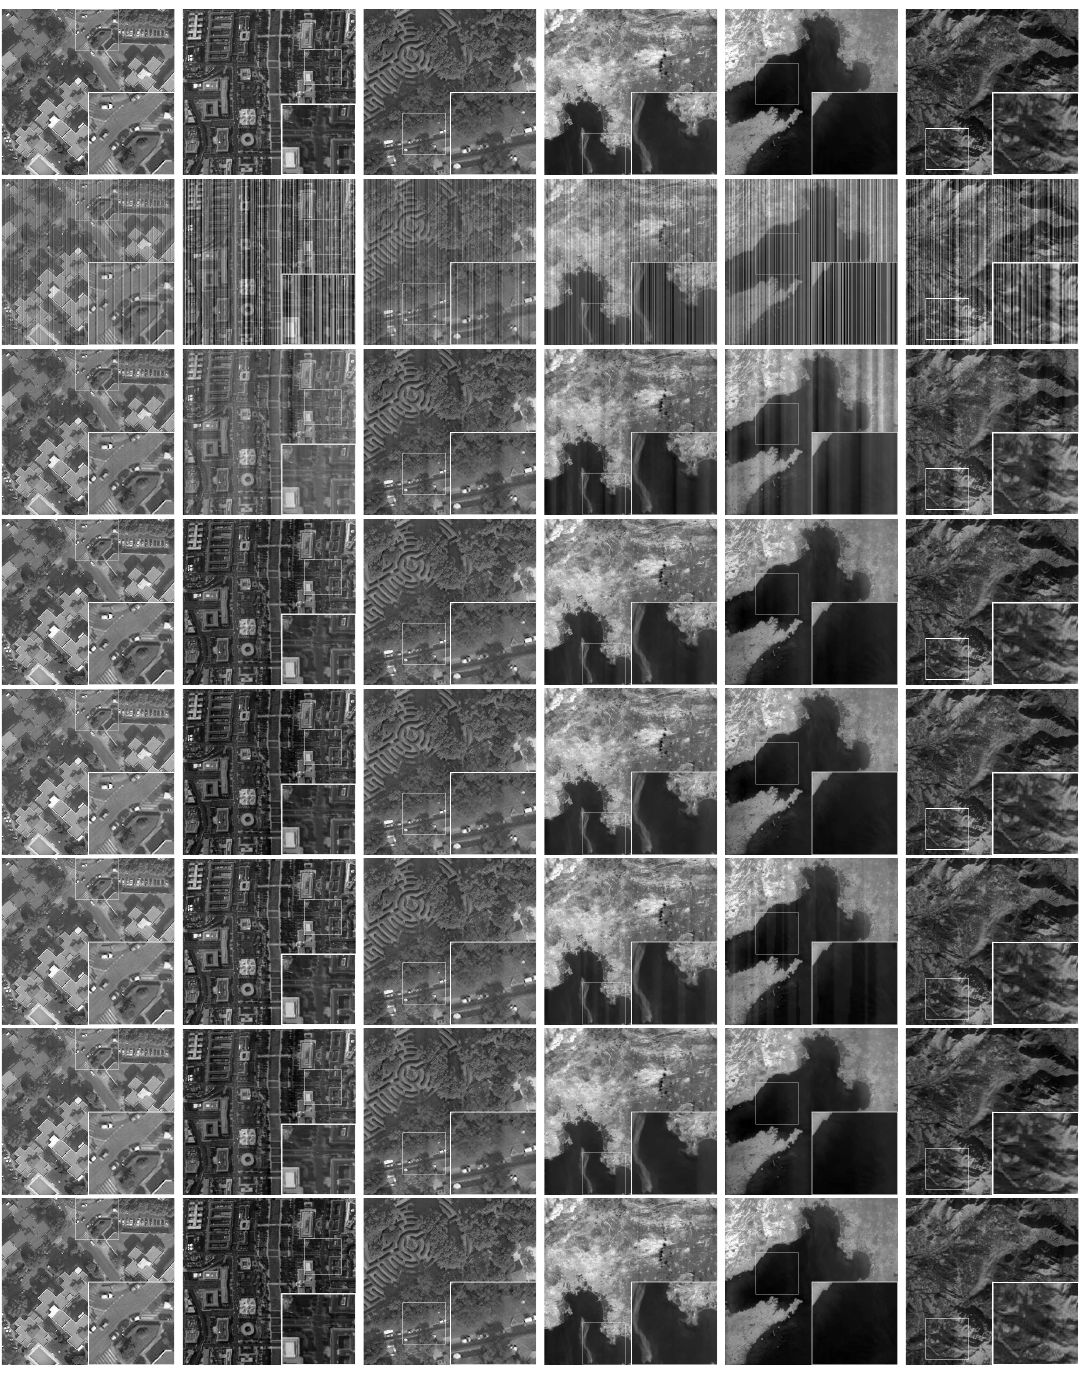
Figure 3. The visual results of different simulated images. From top to bottom: underlying images, degraded images, the destriping results of WFAF, SLD, UTV, GSLV, LRSID, and Ours. The degraded images in the second row are, respectively, added the stripes (from left to right): (Per, 10, 0.2), (NonPer, 100, 0.4), (NonPer, 50, 0.2), (NonPer, 60, 0.4), (NonPer, 100, 0.4) and (NonPer, 50, 0.6). Readers are recommended to zoom in all figures for better